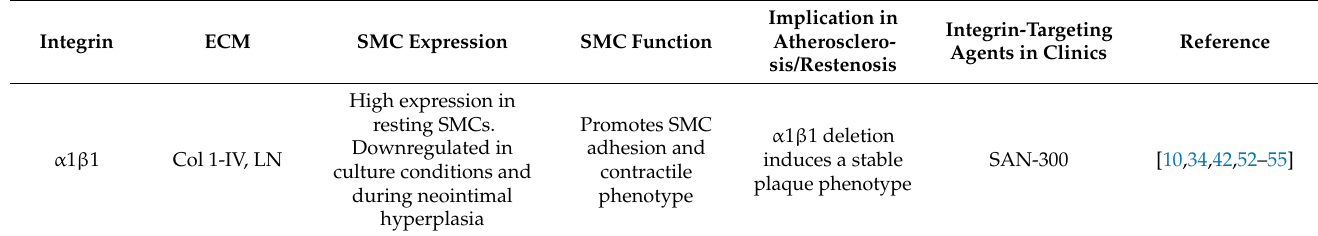
Table 1. Table representing the expression of different integrin subunits, their implication in smooth muscle cell (SMC) function and disease conditions such as atherosclerosis and neointimal hyperplasia, and integrin-directed drugs used in clinics. Collagen, Col; Laminin, LN; Fibronectin, Fn; Vascular cell adhesion molecule, VCAM; Osteopontin, OPN; Tenascin, TN; Vitronectin, VN; Fibrinogen, Fib; EDA, extra domain